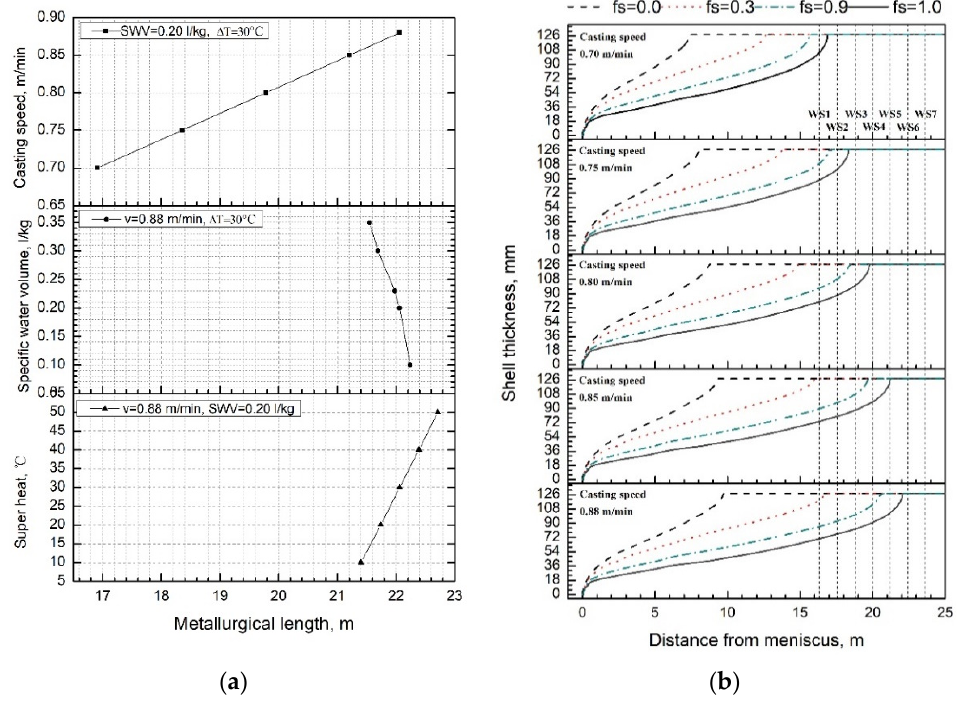
Figure 5. ( a ) Influence of casting condition on metallurgical length of steel GCr15; ( b ) solid fraction isolines at different casting speed of GCr15 steel.